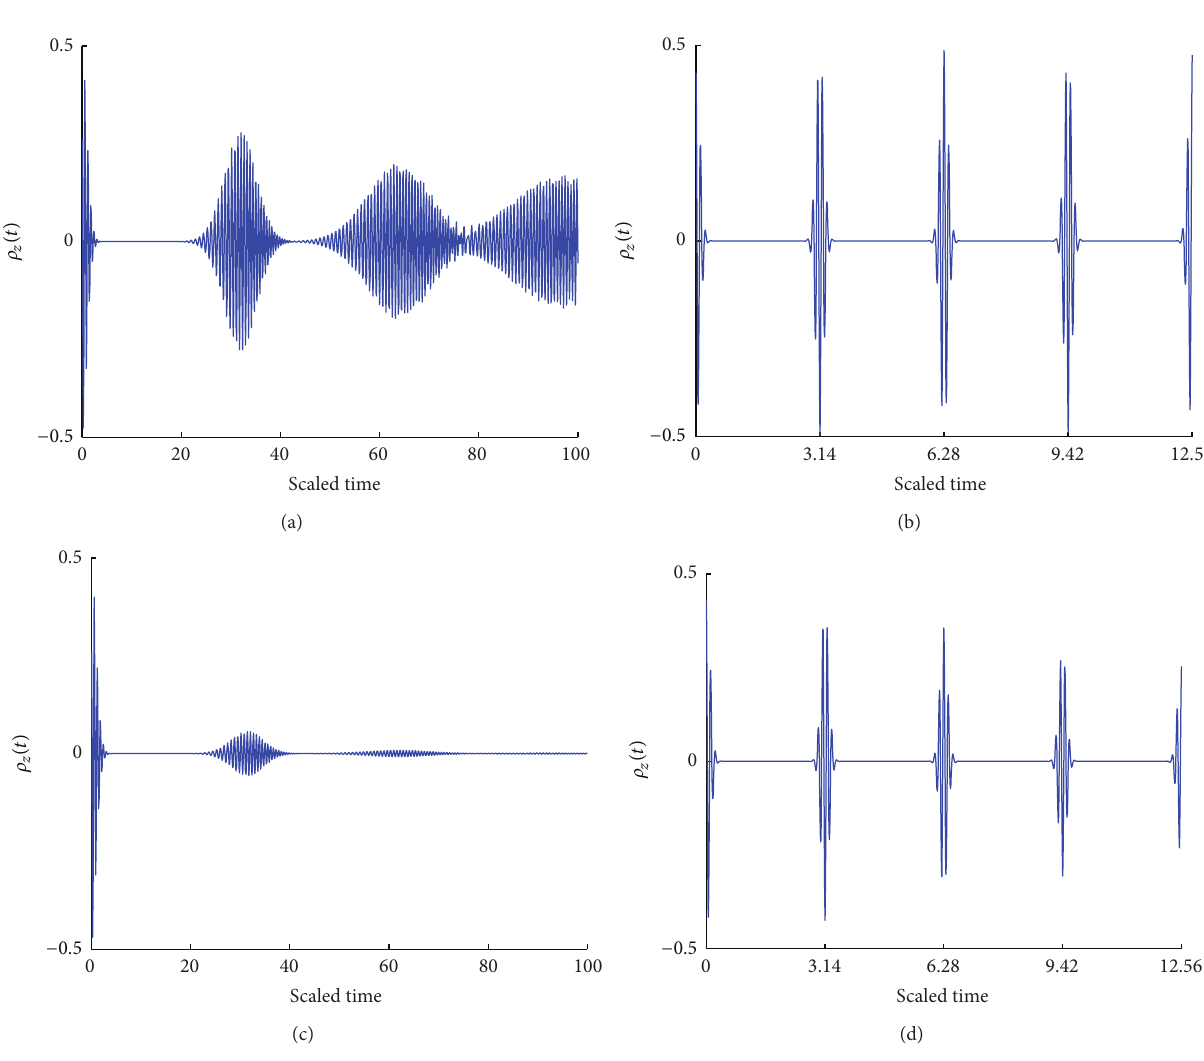
Figure 1: The evolution of the atomic population inversion 𝜌 𝑧 (𝑡) as a function of the dimensionless time 𝜆𝑡 for 𝛼 = 5 and with different values of the number of photon transition 𝑘 and atomic damping parameter 𝛾/𝜆 where (a) (𝑘,𝛾/𝜆) = (1,0.0001) , (b) (𝑘, 𝛾/𝜆) = (1, 0.1) , (c) (𝑘,𝛾/𝜆) = (2,0.0001) , and (d) (𝑘,𝛾/𝜆) = (2,0.1)